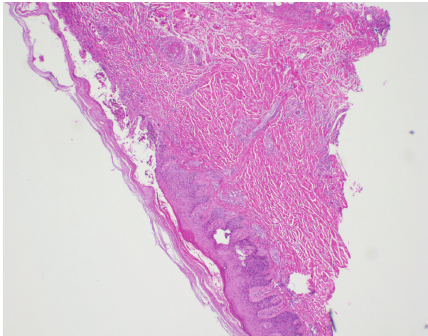
Figure 1: Skin biopsy in low power field showing leukocytoclastic vasculitis.